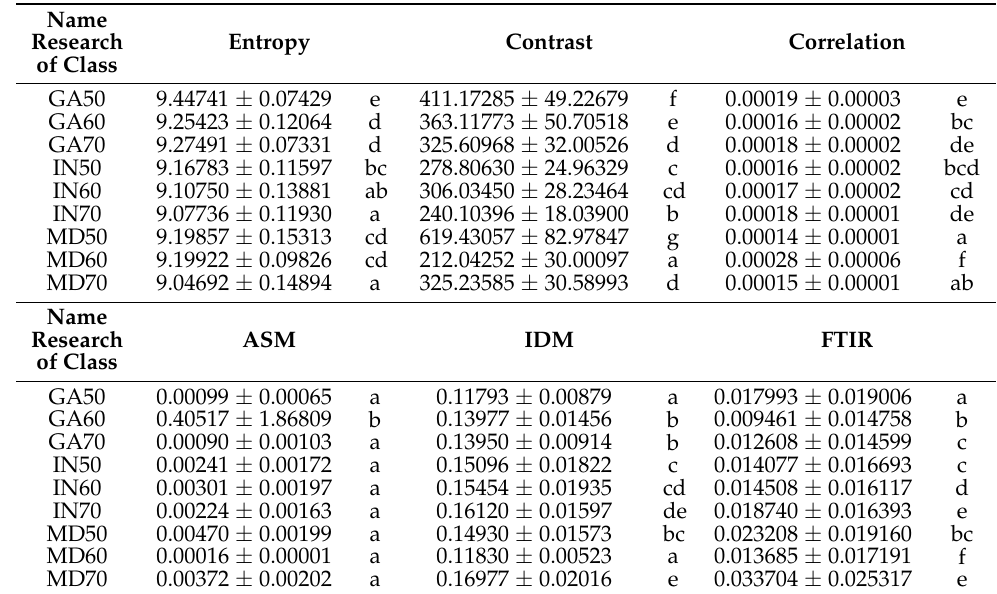
Table 4. Texture analysis and FTIR of raspberry powders containing 50, 60, and 70% of raspberry con- centrate solids obtained with gum arabic (GA), inulin (IN), and maltodextrin (MD) by dehumidified air-assisted spray